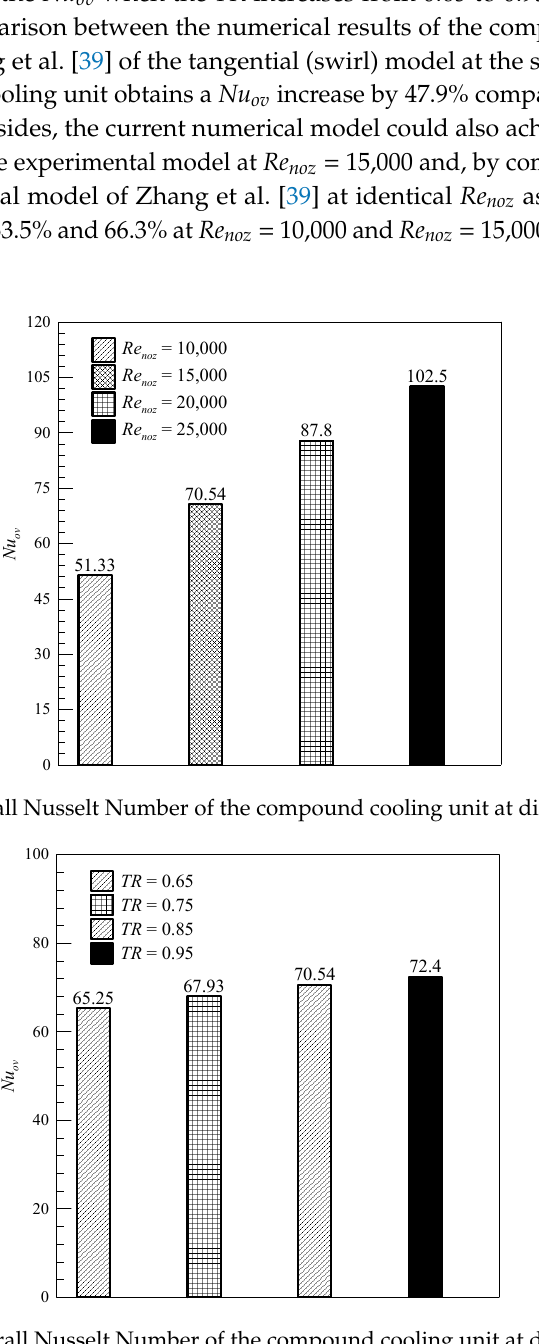
Figure 19. Overall Nusselt Number of the compound cooling unit at different TR .